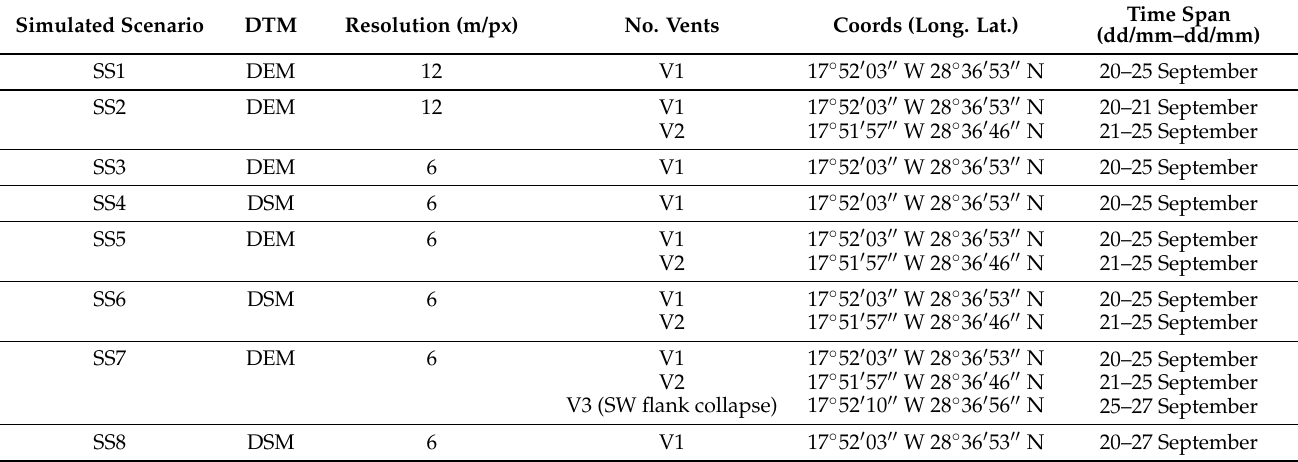
Table 2. Simulation plan designed to evaluate real-time replication capabilities and estimate flow rate and lava rheology. DTM used specified whether the terrain model included obstacles (DSM) or if it was bare terrain